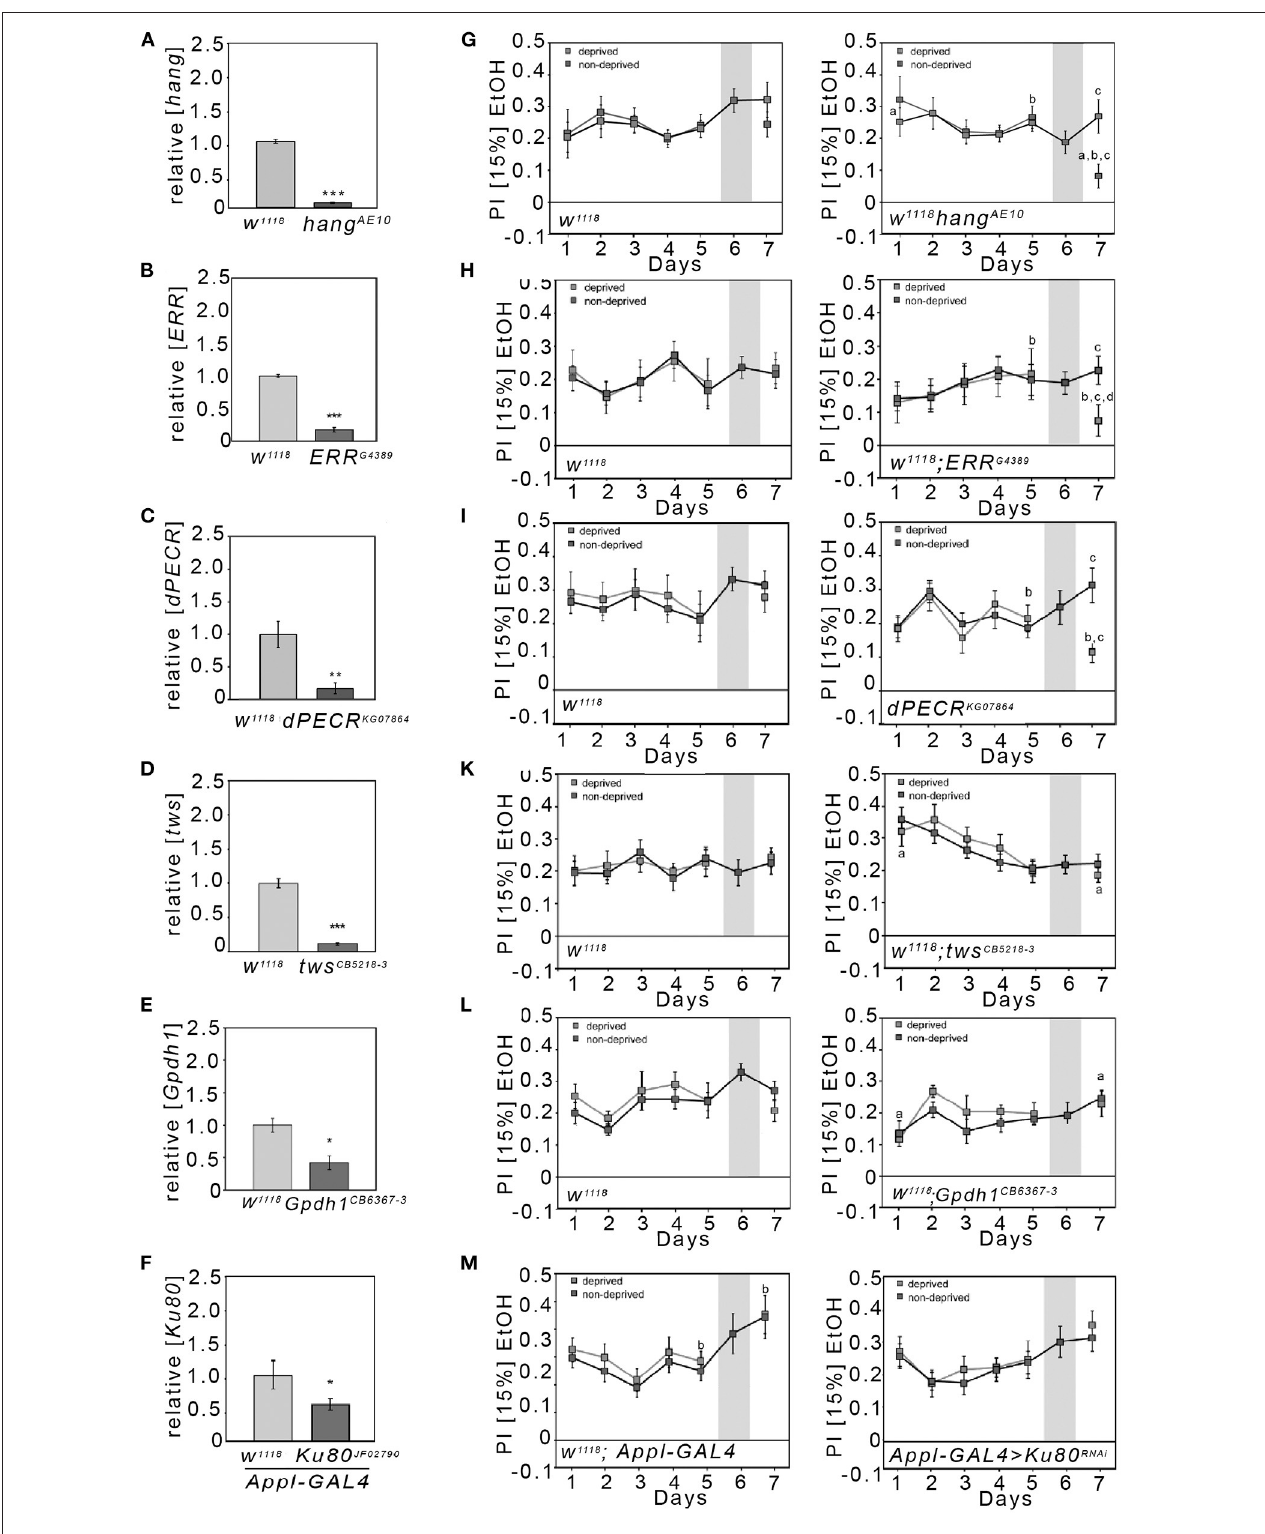
FIGURE 2 | Reduction in the preference to consume EtOH after abstinence in hang , ERR , and dPECR mutants. (A–F) The qRT-PCR analysis performed on polyA -selected head RNA revealed a significant reduction in transcripts of candidate genes (transcript levels for hang AE 10 : 0.08 ± 0.01; for ERR G 4389 : 0.17 ±